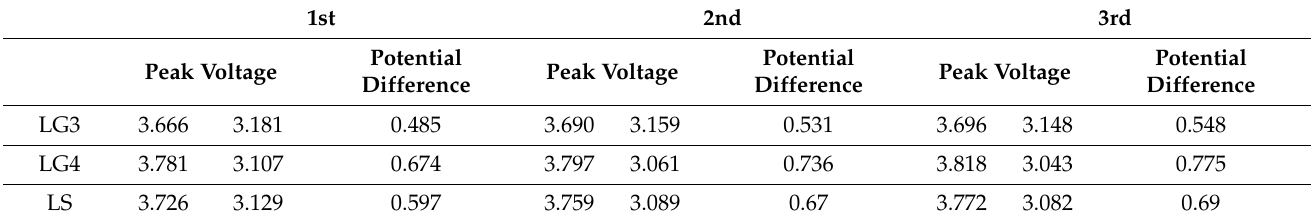
Table 4. The data of peak voltage and potential difference in the cyclic voltammogram.